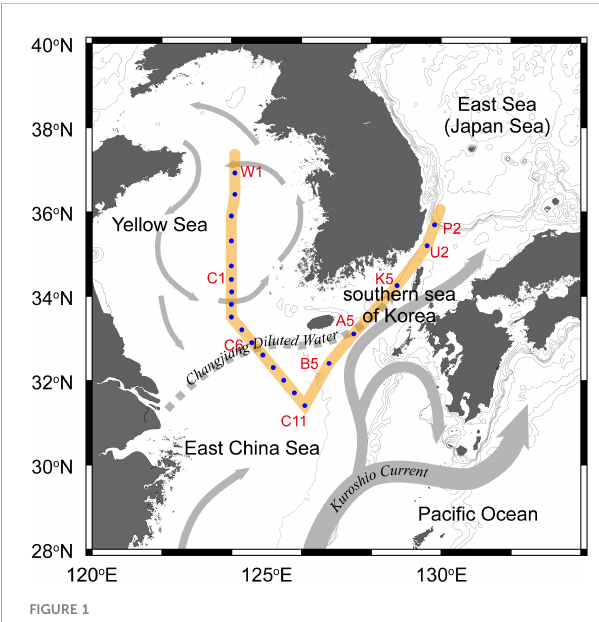
FIGURE 1 Map of the sampling stations, bottom topography, and simple schematic patterns of surface currents in the northwestern Paci fi c marginal seas. The bold color line in yellow indicates the transect used in this study. The arrows indicate the current systems in operation during the sampling